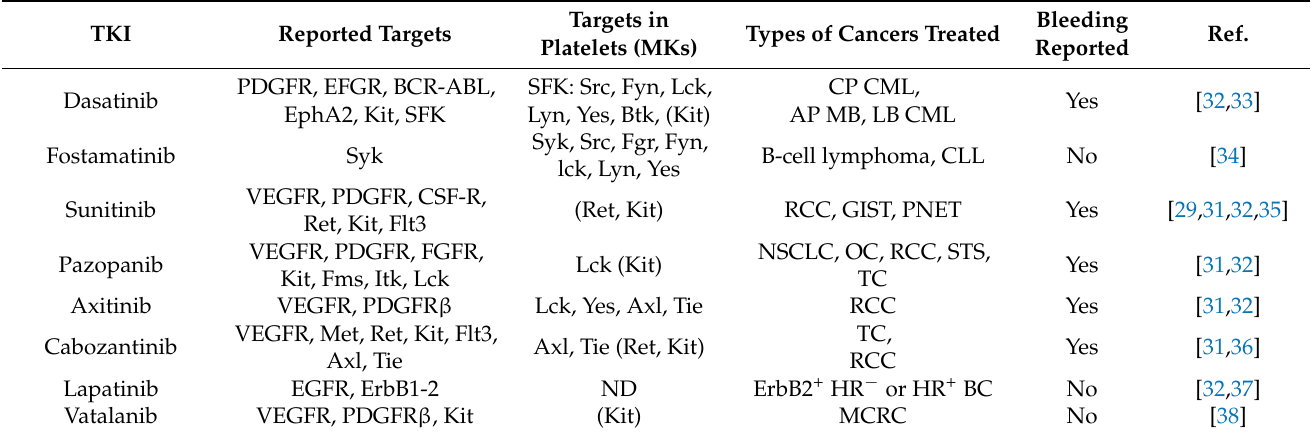
Table 1. Characterization of TKIs used for cancer treatment, with targets present in platelets.